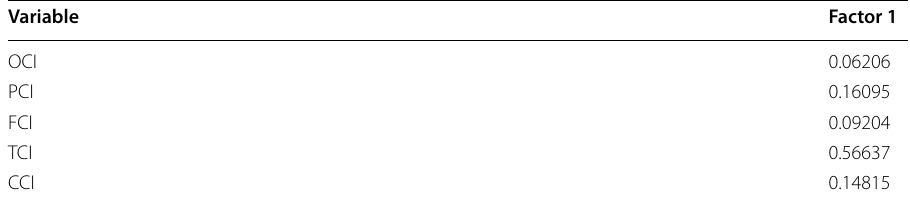
Table 12 Scoring